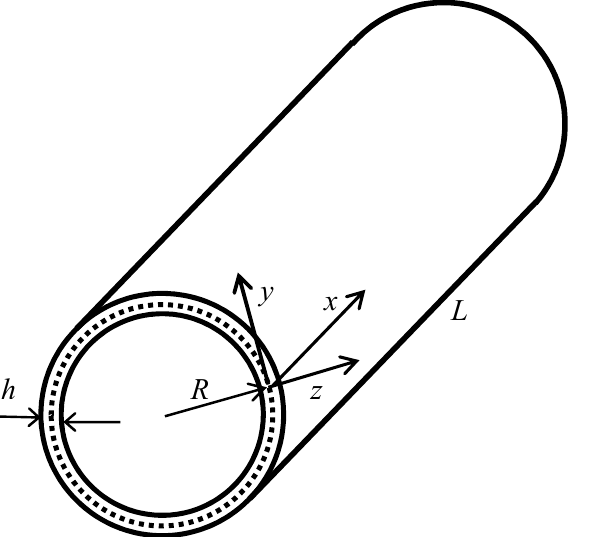
Figure 1. The geometry of the circular cylindrical shell.